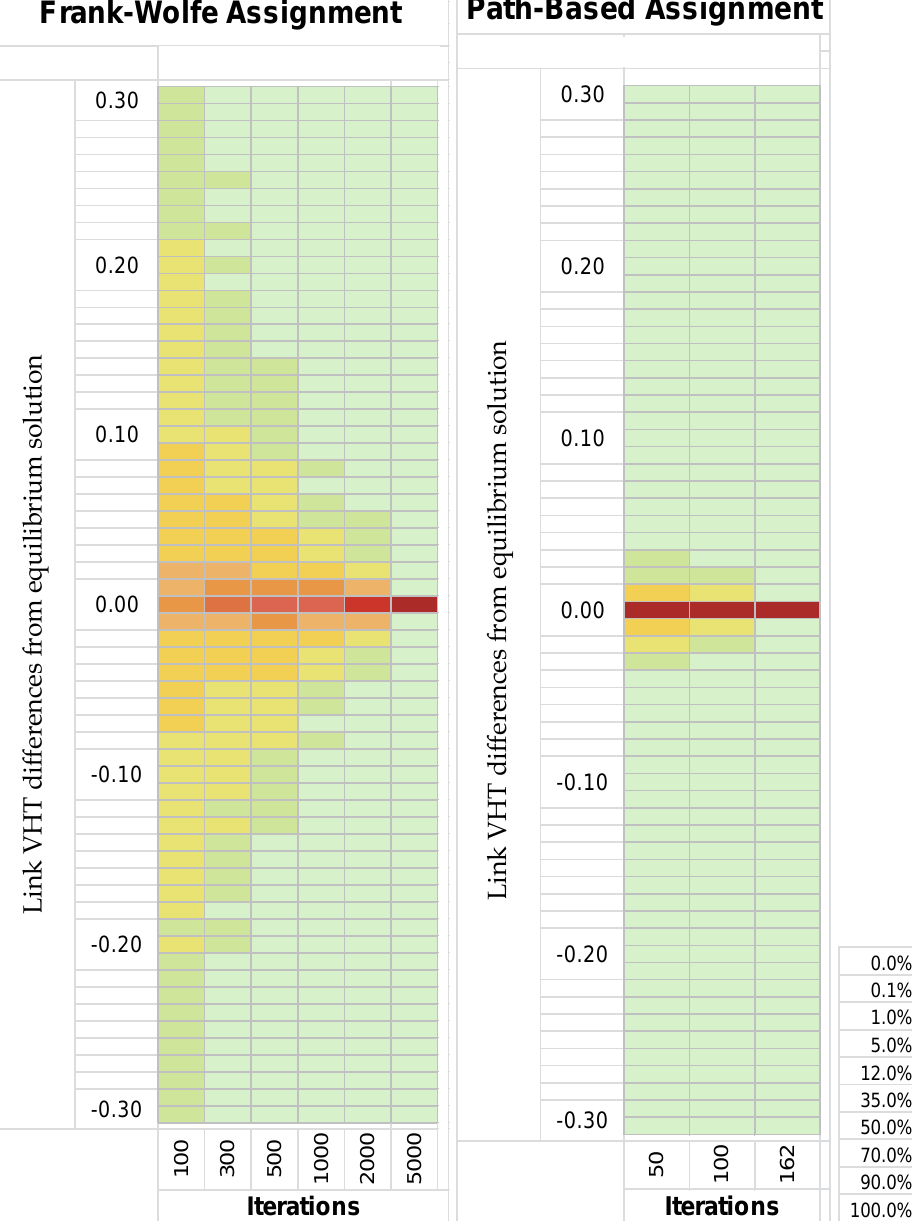
Figure 4. Distribution of link VHT differences for FW and PBTA